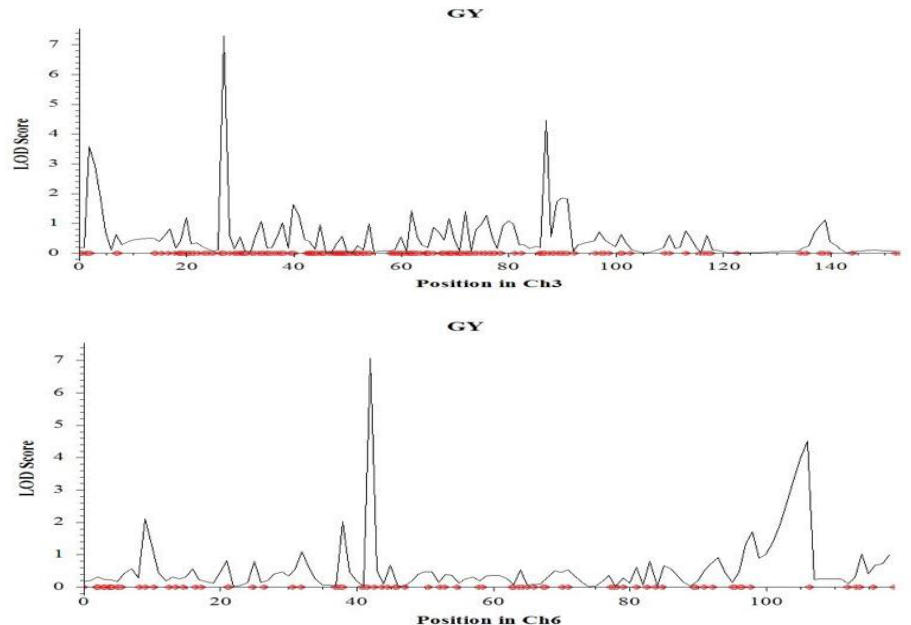
Figure 8. Chromosome locations of QTLs for grain yield per plant under salinity stress based on a significant threshold of LOD 3.0 using ICIMapping on: chromosome 3 and chromosome 6. The hor- izontal line indicates the significant LOD threshold at 95% confidence levels based on 1000 permu- tations.